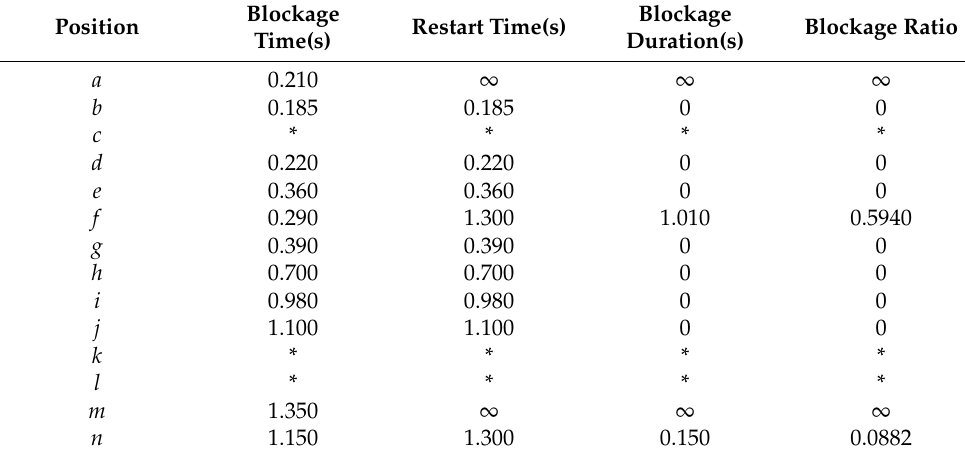
Figure 13. Schematic diagram of the blocking effect in the capillary tube. Different flow paths are distinguished by a–c.